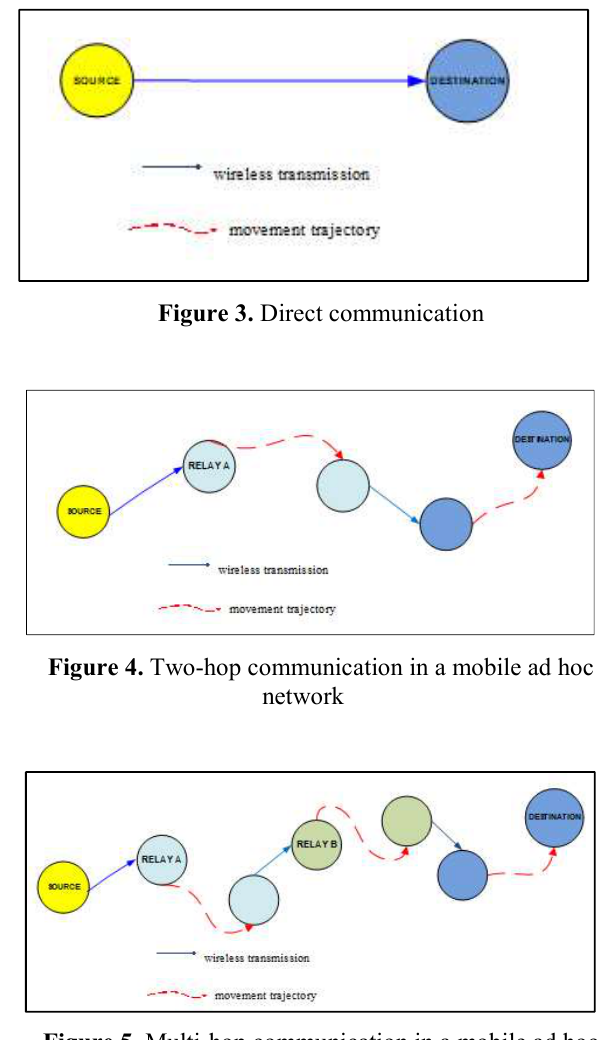
Figure 5. Multi-hop communication in a mobile ad hoc